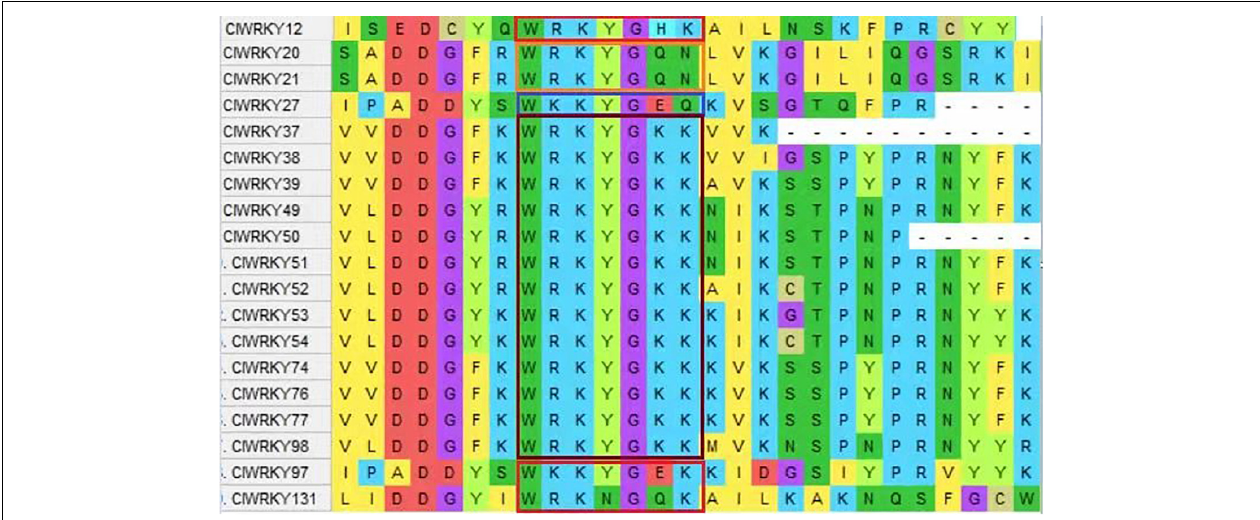
FIGURE 1 | A screenshot of the MEGA X version 10.2.6, showing variation in the conserved domain (WRKYGQK) of ClWRKY proteins, and the variation of the conserved domain is encircled in different